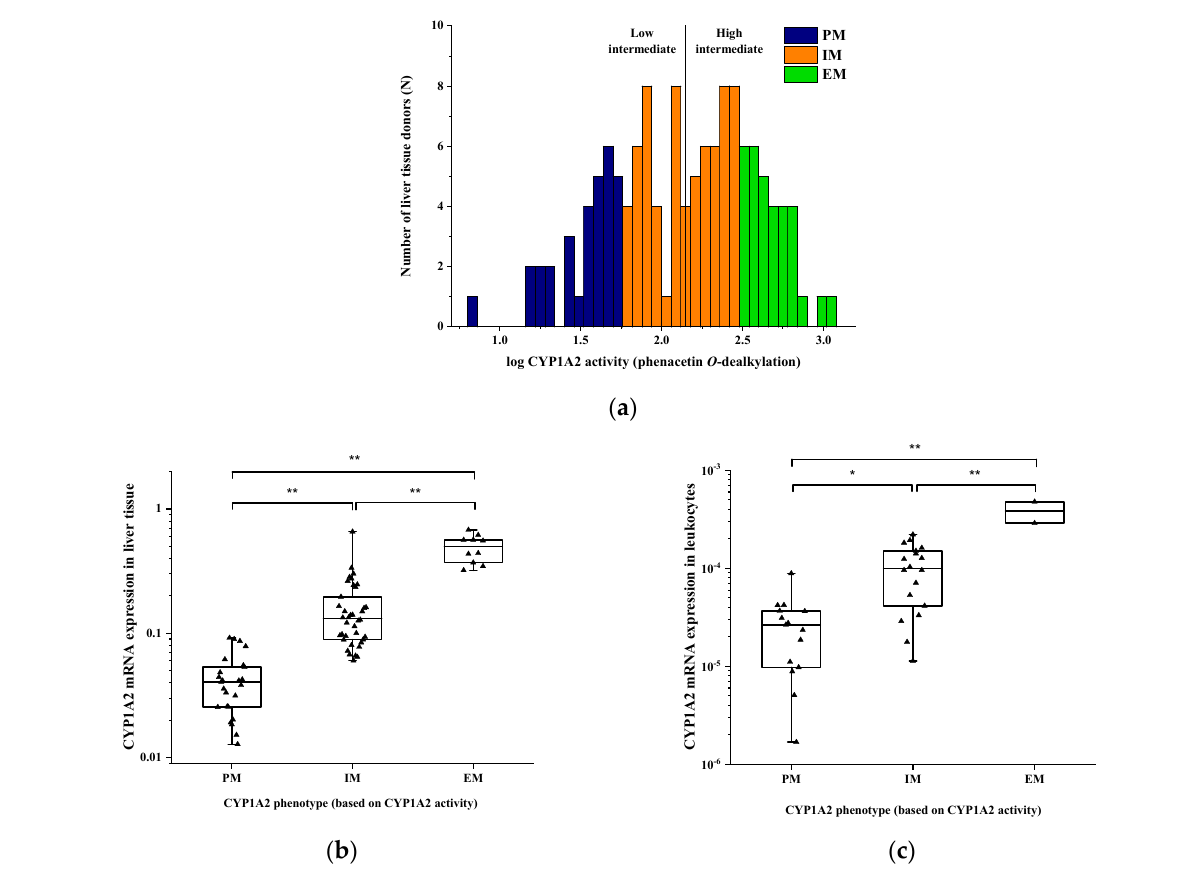
Figure 1. CYP1A2 activities and expression in liver tissue donors: ( a ) Frequency distribution of hepatic CYP1A2 activities (phenacetin O -dealkylation); ( b ) association between CYP1A2 activities and mRNA expression in the liver or ( c ) mRNA expression in the peripheral leukocytes of human tissue donors. Abbreviations: PM, poor metabolizer; IM, intermediate metabolizer; EM, normal metabolizer. The vertical line between low and high intermediate metabolizers indicates the median activity. In ( b ) and ( c ), the boxes display the range; the horizontal lines are for the median, and the whiskers are for the minimum-maximum values. * p < 0.01; ** p < 0.001.